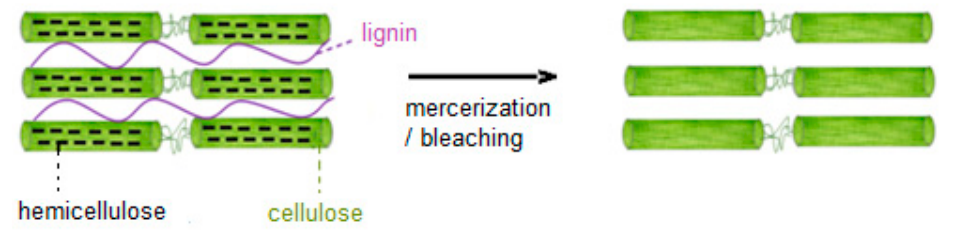
Figure 2. Representative diagram of the purification of natural fiber by alkaline peroxide.